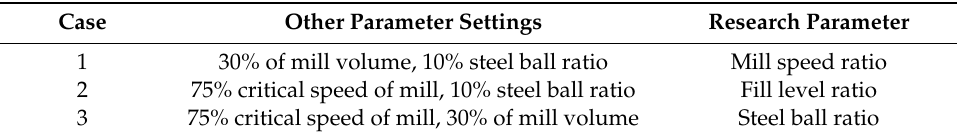
Table 4. Single parameter experimental design.